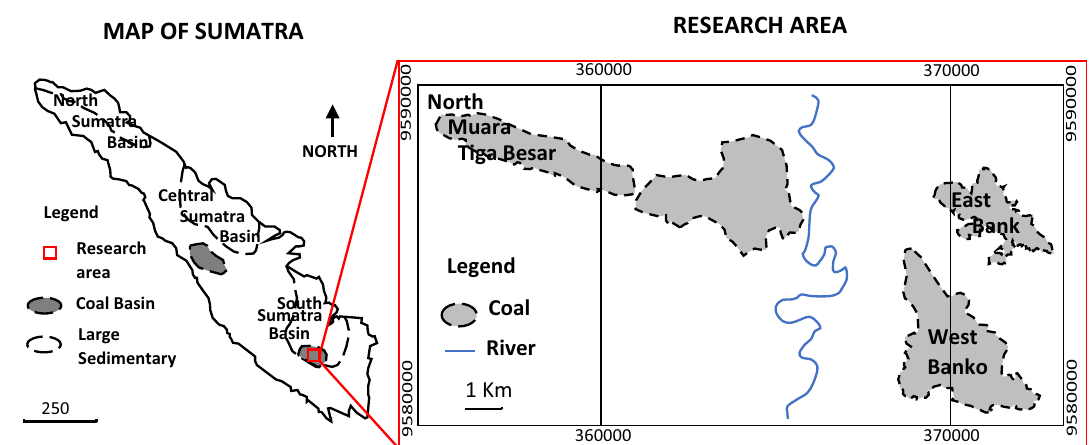
Fig. 2 The location of the research area in South Sumatra Basin, Indonesia Fig. 3 The lithotype of coal samples from a WB, b EB,